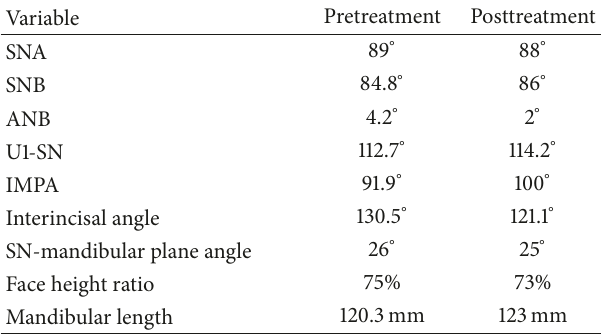
Table 2: Pretreatment and posttreatment cephalometric